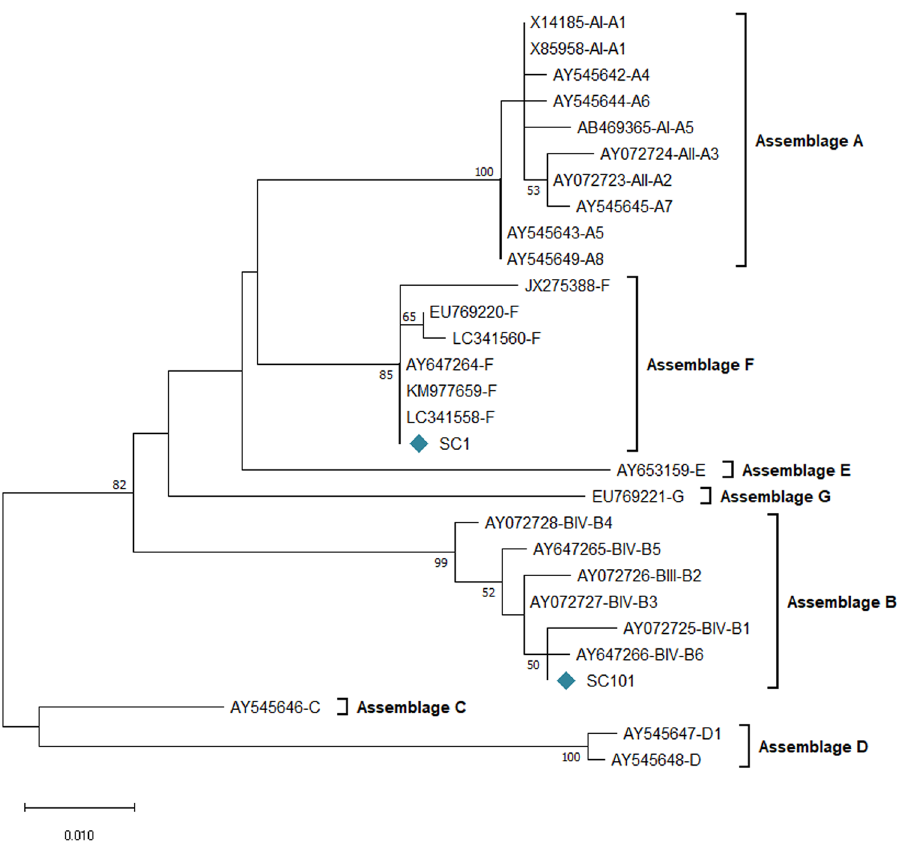
Figure 2. The phylogram of Giardia duodenalis was inferred based on the nucleotide sequences of the β-giardin ( bg ) gene. The evolutionary relationship of G. duodenalis was constructed by the Maximum Likelihood method and Kimura 2-parameter model, based on the nucleotide sequences of the bg gene of G. duodenalis isolated from stray cats [SC] in this study (light sea green rhombus) compared with nucleotide sequences of known assemblages retrieved from GenBank. Bootstrap values obtained from 1000 replicates are indicated on branches in percentage; only bootstrap values > 50% are displayed. Evolutionary analyses were conducted in MEGA